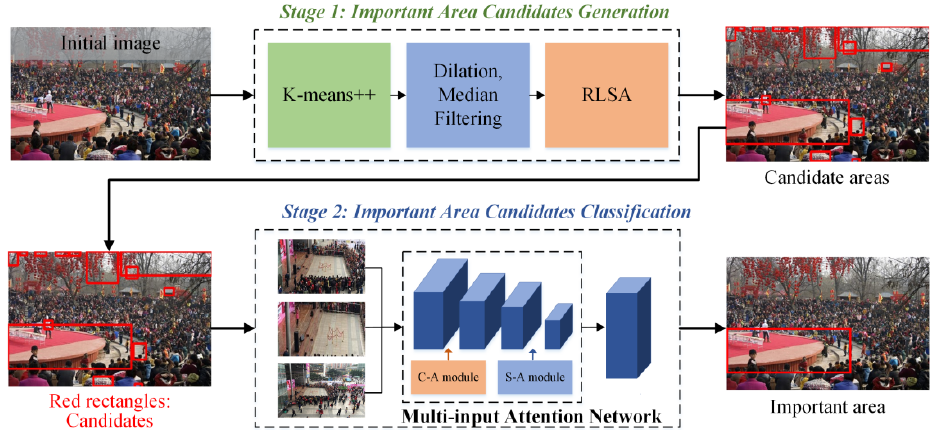
Figure 2. Overview of the proposed two-stage important area detection method. The method is built based on classification structure.